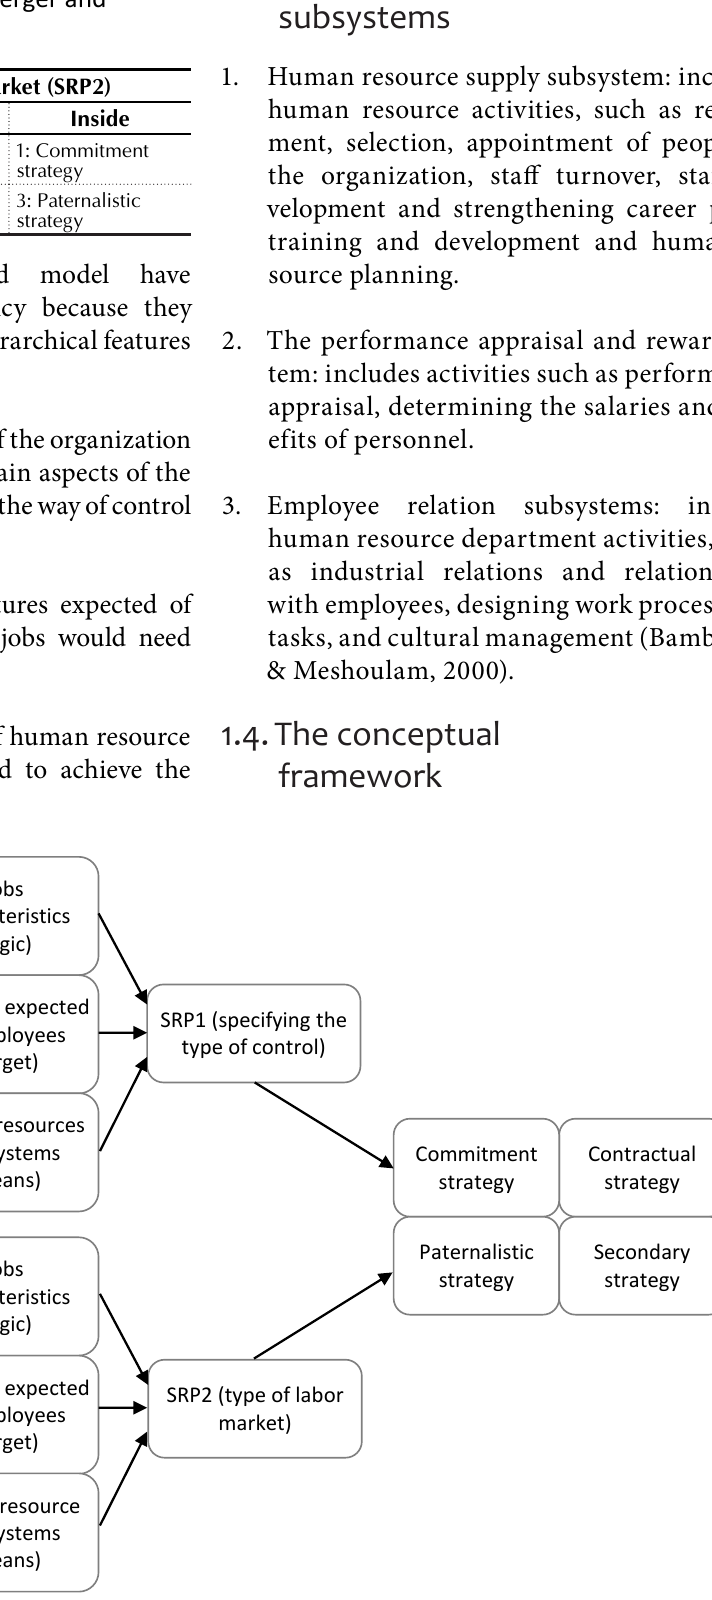
Figure 1. Conceptual